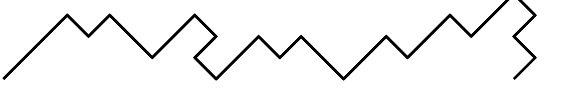
Figure 5. The skew Dyck path corresponding to Figure